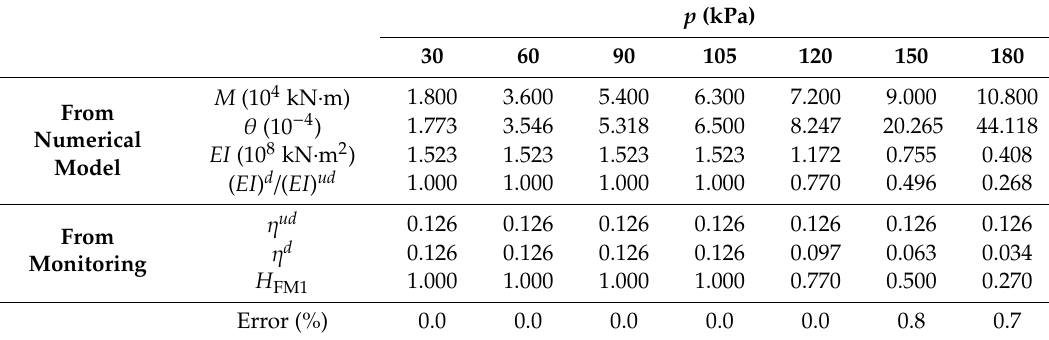
Table 8. Comparison between ( EI ) d / ( EI ) ud and H FM1 in